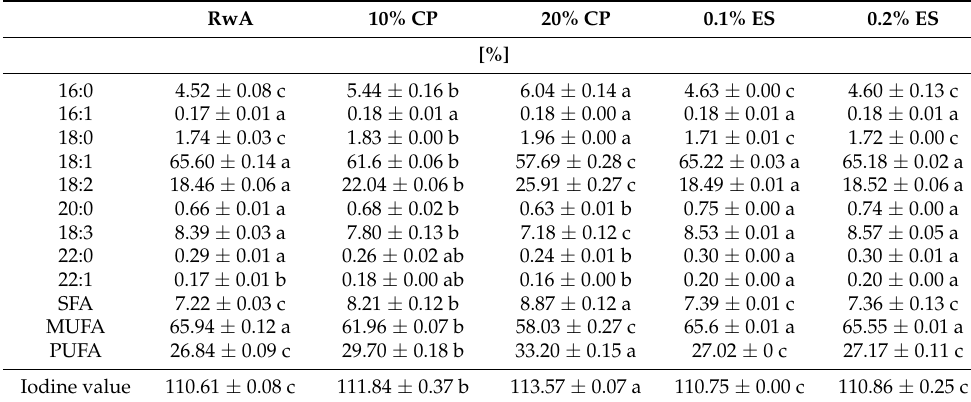
Table 2. Fatty acid composition and iodine value in nonheated